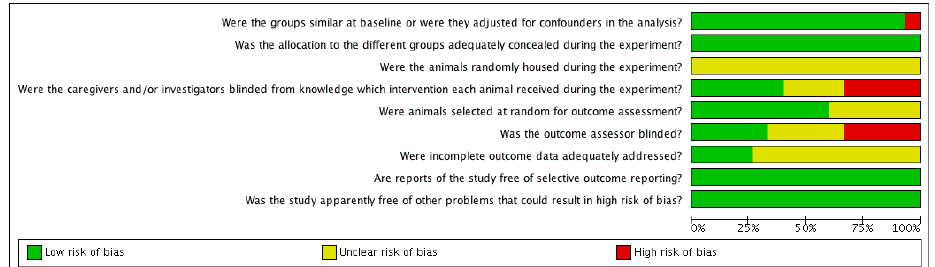
Figure 2. Methodological quality graph: review authors’ judgements about each methodological quality item presented as percentages across all included studies.